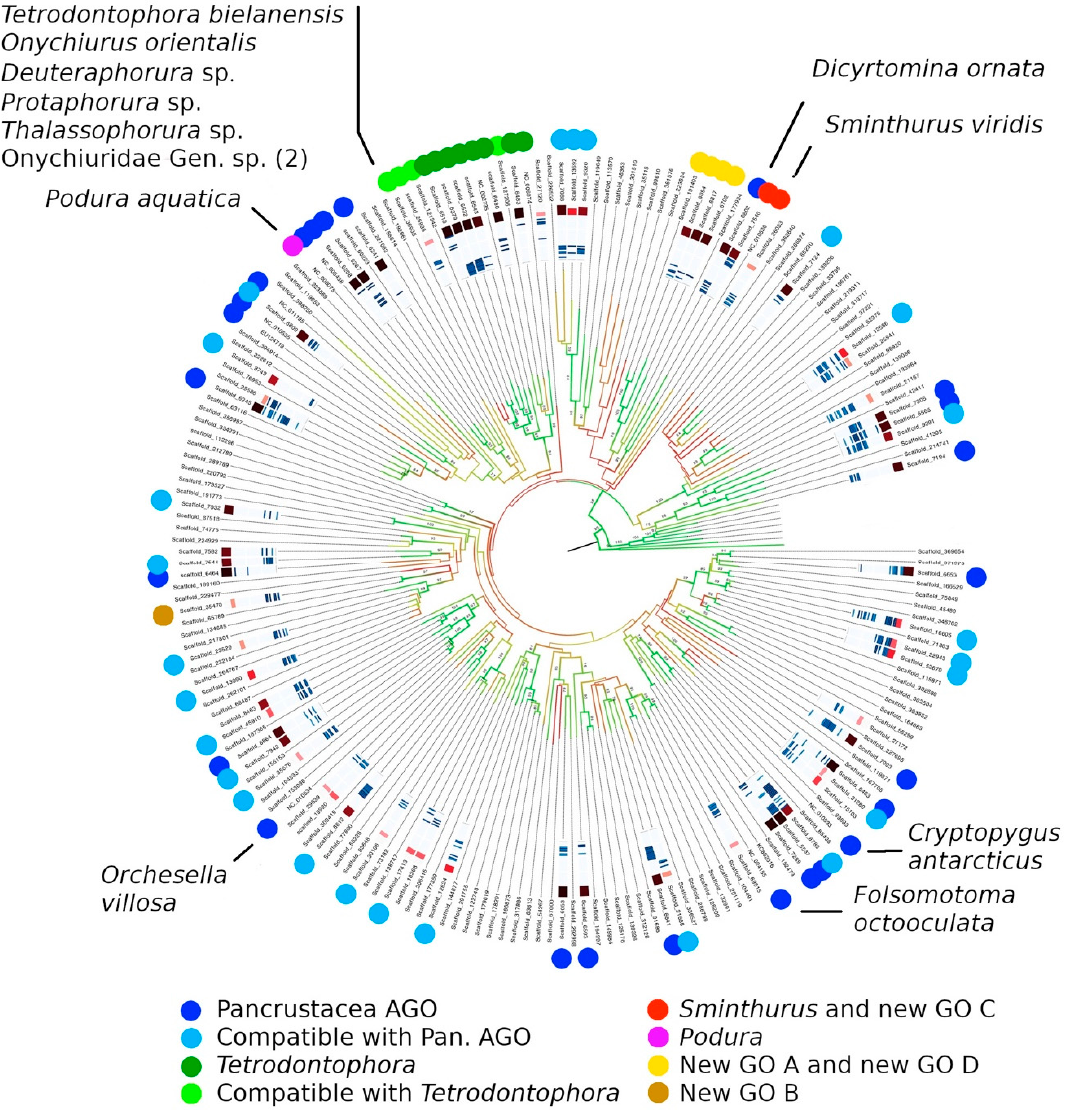
Figure 4. Gene orders observed in Collembola (color coded), overlaid over the phylogenetic tree of